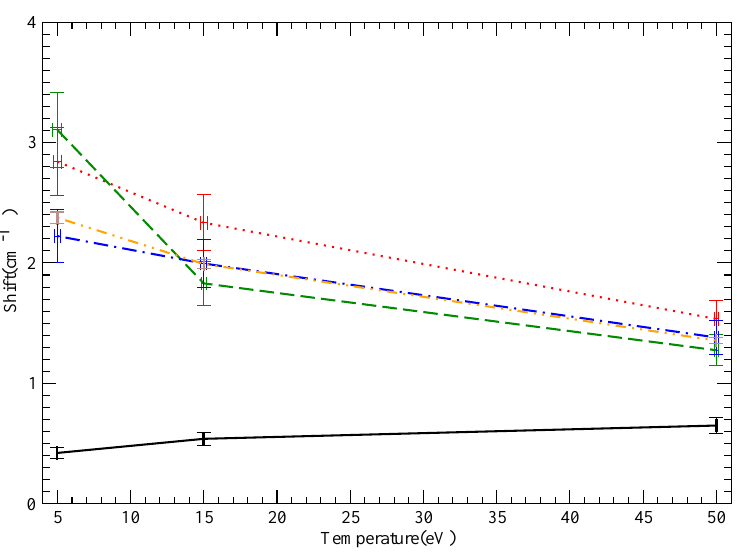
Figure 10 plots the shifts computed by five codes vs. electron temperature T . Figure 10. A comparison of hyperbolic and straight line trajectories for the NV 2s-2p transition widths, as computed by SCP-hyperbolic (solid), SCP-straight (dotted), SimU-hyperbolic (dashed), SimU-straight (dash-dotted) and Simulation (dash-double